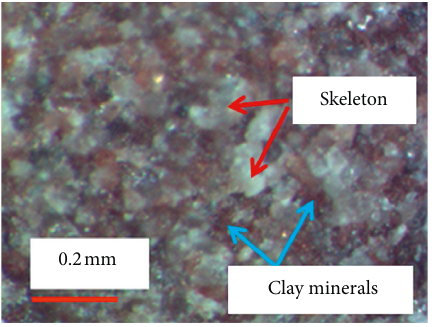
Figure 1: Image of a typical argillaceous siltstone in